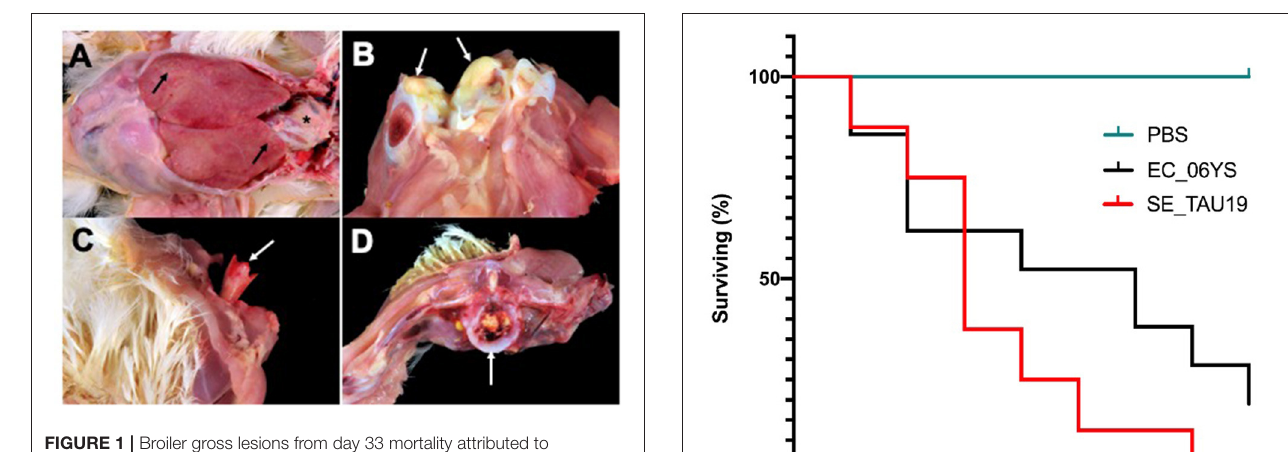
FIGURE 1 | Broiler gross lesions from day 33 mortality attributed to septicemic disease caused by Salmonella Enteritidis (SE) strain SE_TAU19. (A) Fibrinous pericarditis (asterisk) and multifocal necrotizing and heterophilic hepatitis (black arrows). (B) Hock joint, fibrinous arthritis (white arrows). (C) Bacterial chondronecrosis with osteomyelitis (femoral head necrosis) (white arrow). (D) Vertebral osteomyelitis (white arrow).